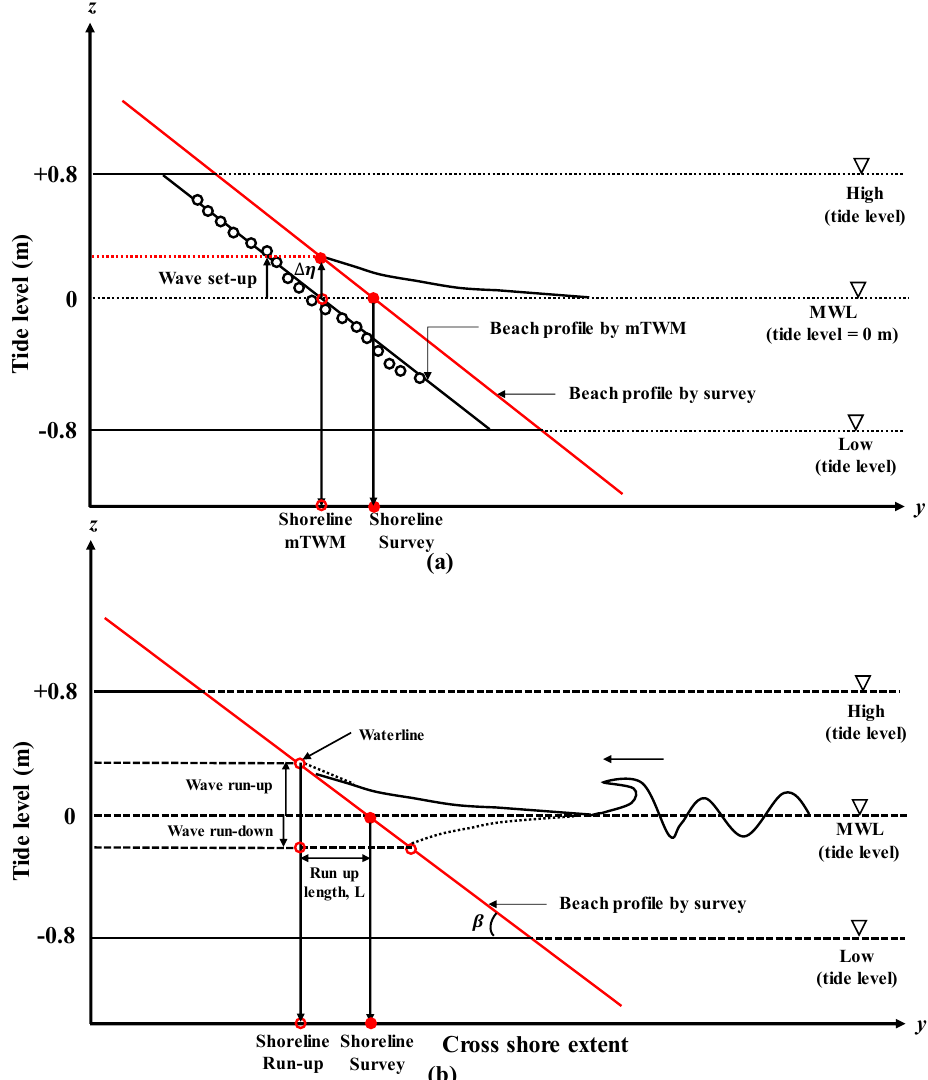
Figure 13. Spatial and temporal variations in ( a ) the shoreline positions and ( b ) the intertidal foreshore slopes estimated by mTWM during 12 April 2005 to 31 December 2008.